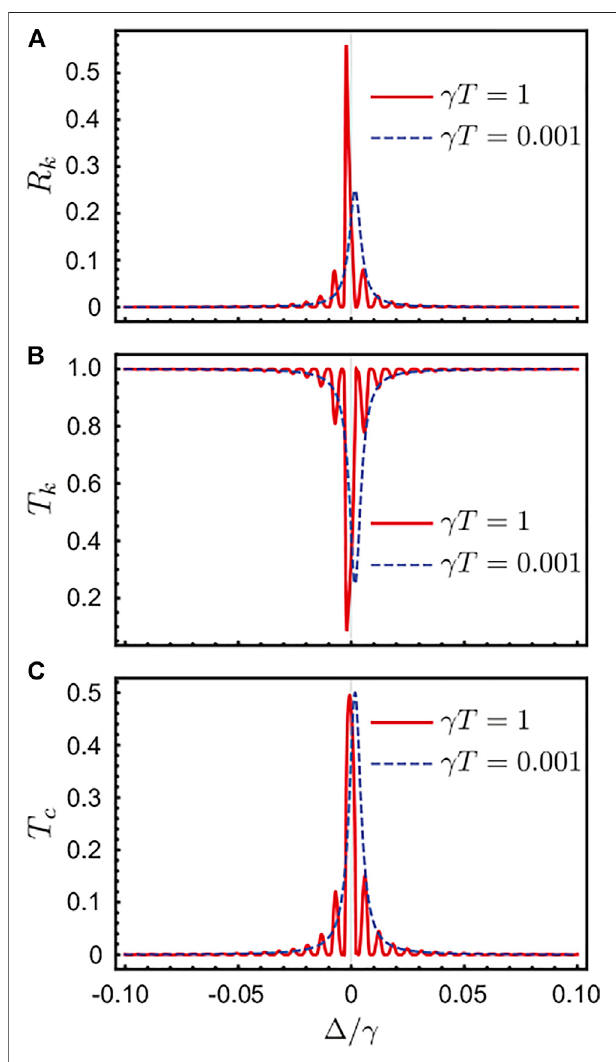
FIGURE 4 | The scatting process described by the re fl ectance R k (A) , transmittance T k (B) , and frequency conversion rate T c (C) versus normalized detuning Δ / γ with γ T = 0.001 (dashed bule line) and γ T = 1 (solid red line).